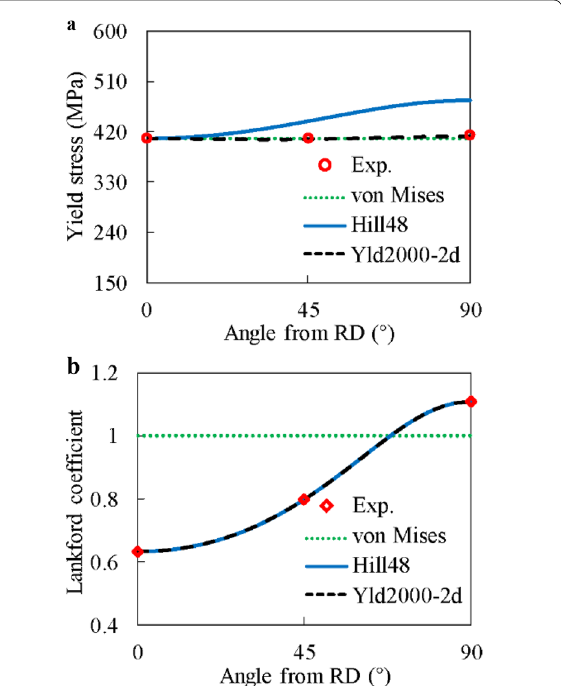
Figure 14 Comparison of calculated and experimental ( a ) uniaxial yield stresses and ( b ) r -values at various angles to the RD at 130